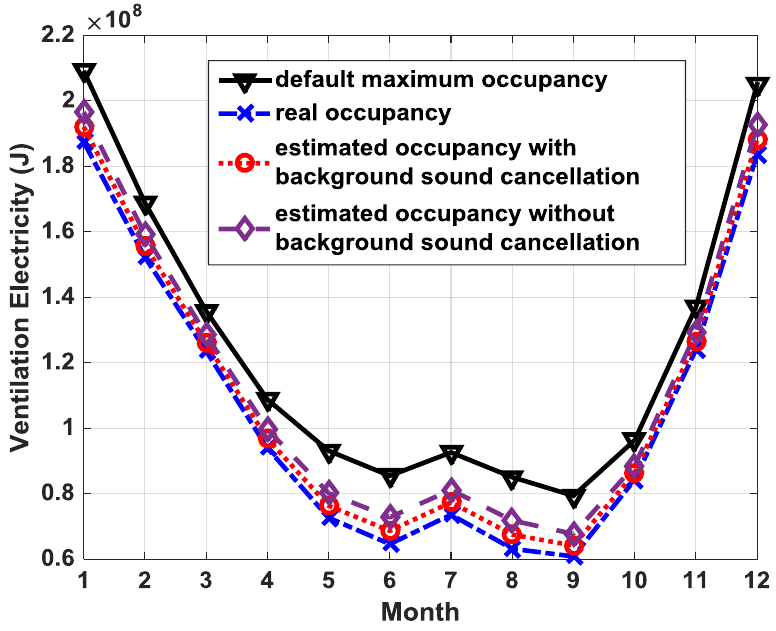
Figure 6. Simulation results of monthly ventilation electricity for a one-year period.